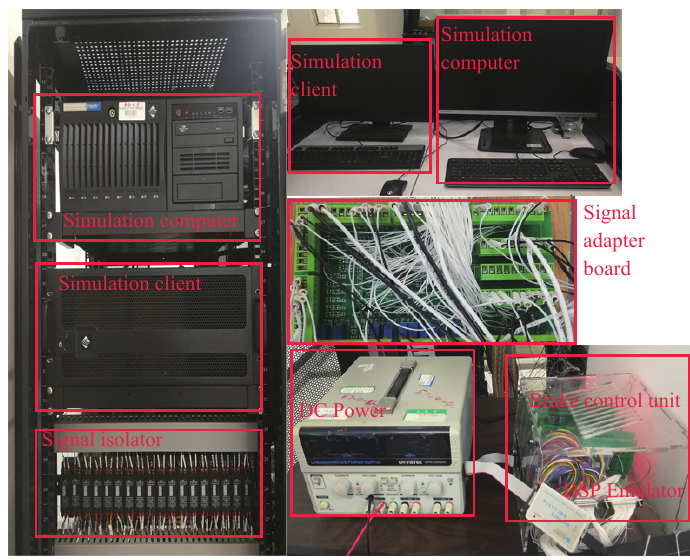
Figure 14. The hardware-in-the-loop experimental setup.